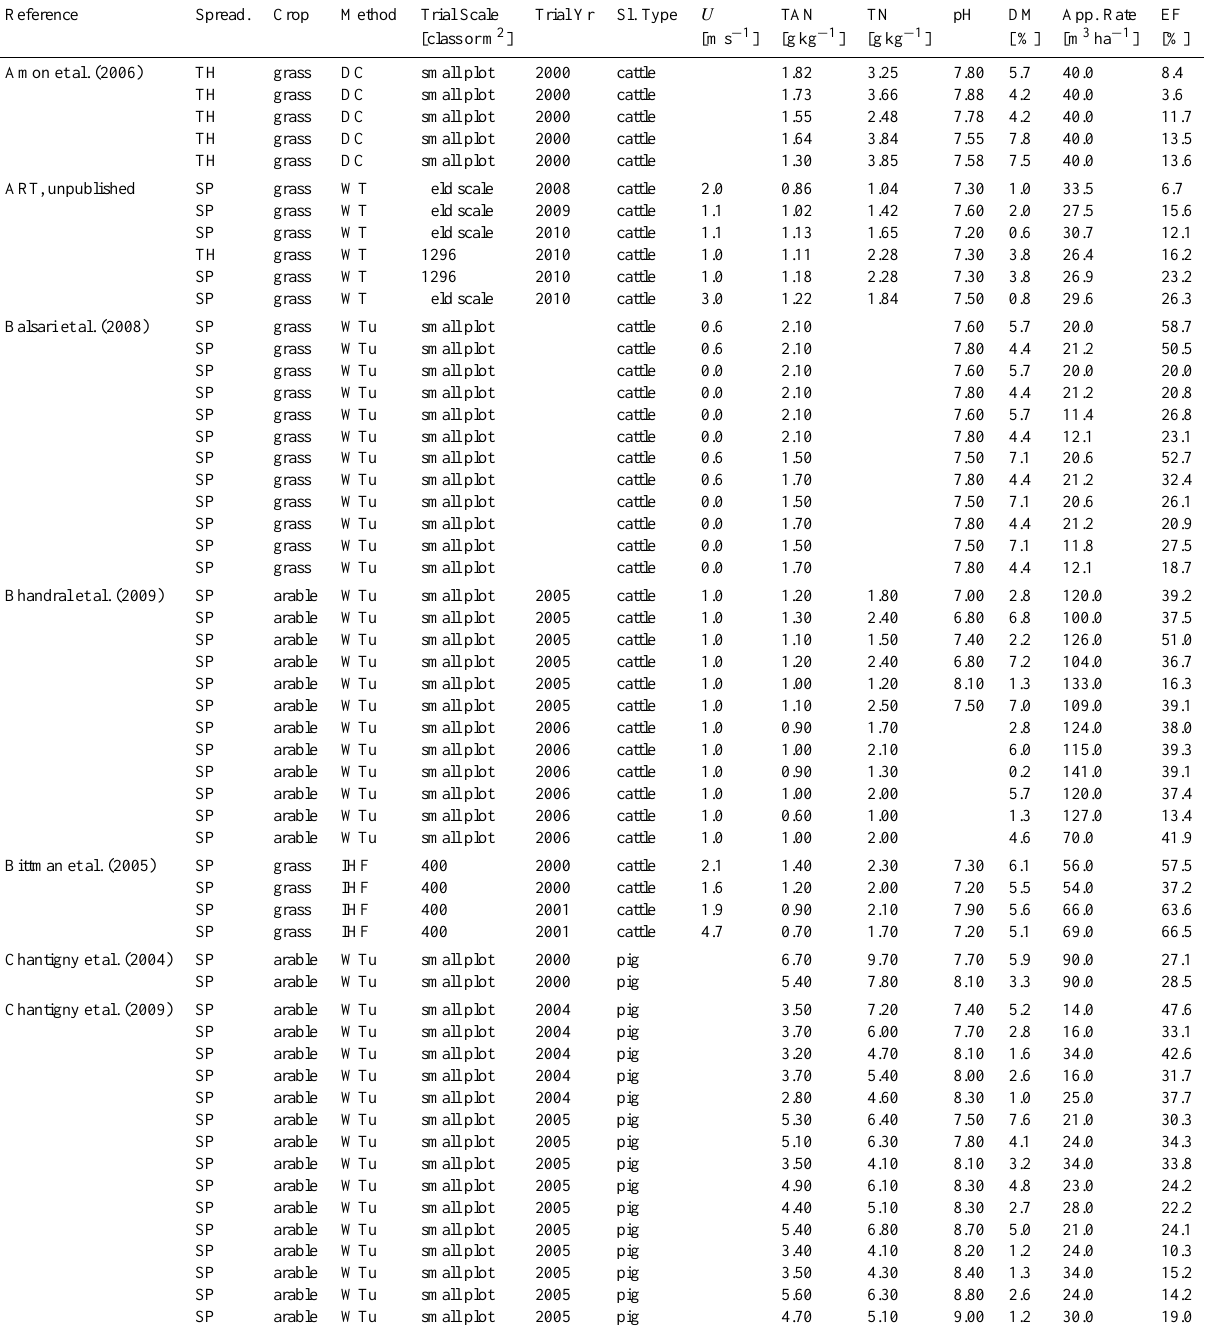
Table A1. Used NH 3 EFs and related data.